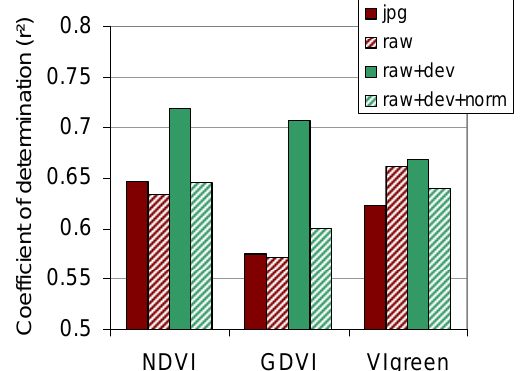
Figure 14. Coefficient of the regression functions between CC (LAI*SPAD) and three vegetation indices (36 experimental plots across six dates). VIs are calculated from the Red, Green and NIR images at different levels of radiometric correction (jpg = JPEG format; raw = unprocessed format; dev = vignetting-corrected; norm = normalized by invariant